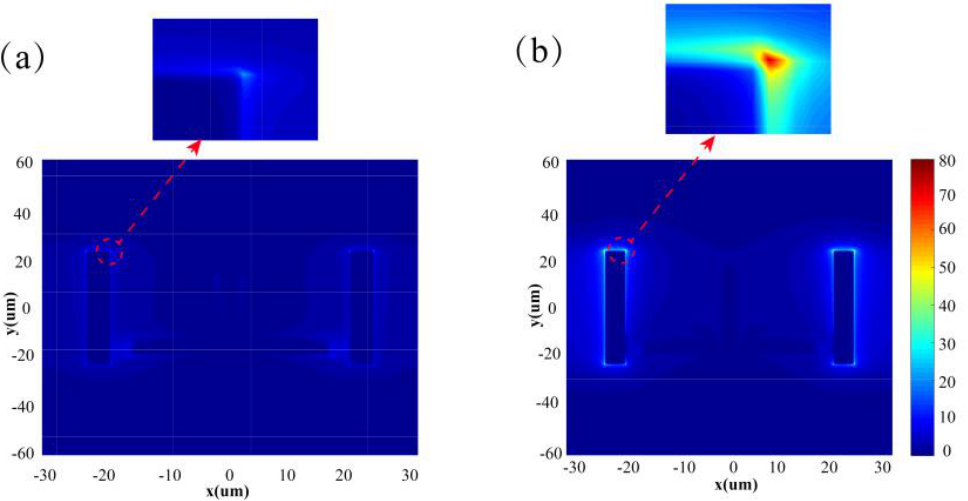
Figure 7. The electric field distribution of the metamaterial on the surface at a frequency of 0.82 THz when the graphene Fermi level is 0.4 eV ( a ) and 1.2 eV ( b ),